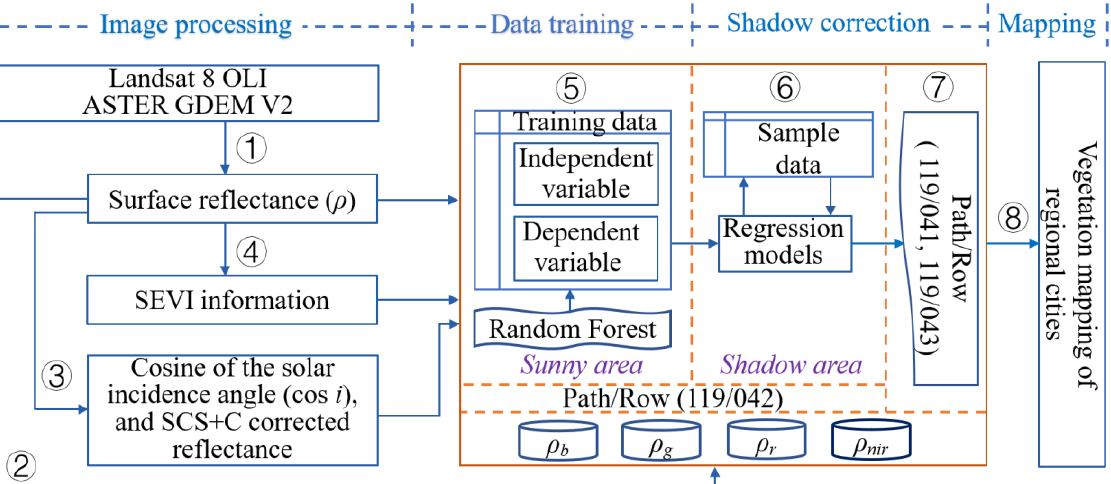
Figure 2. Flow chart of a new integrated topographic correction (ITC) using the SCS + C correction and the shadow-eliminated vegetation index (SEVI): ① atmospheric correction, ② topographic shadow extraction, ③ calculation of the cosine of the solar incidence angle (cos i ) and SCS + C correction, ④ SEVI calculation, ⑤ data training, ⑥ accuracy test, ⑦ applicability test, and ⑧ vegetation mapping. The ρ b , ρ g , ρ r , and ρ nir are the waveband reflectances of blue, green, red, and near-infrared.